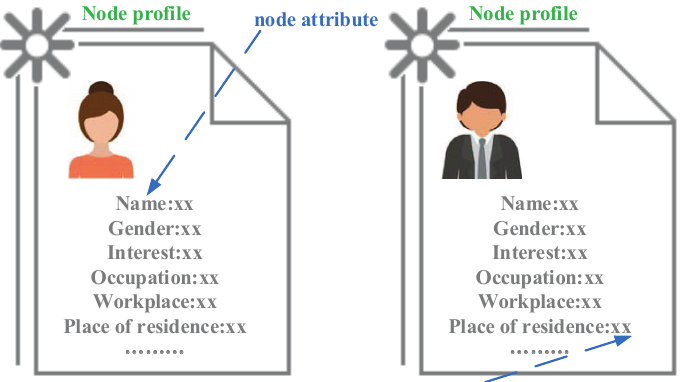
Figure 1. The description diagram of node